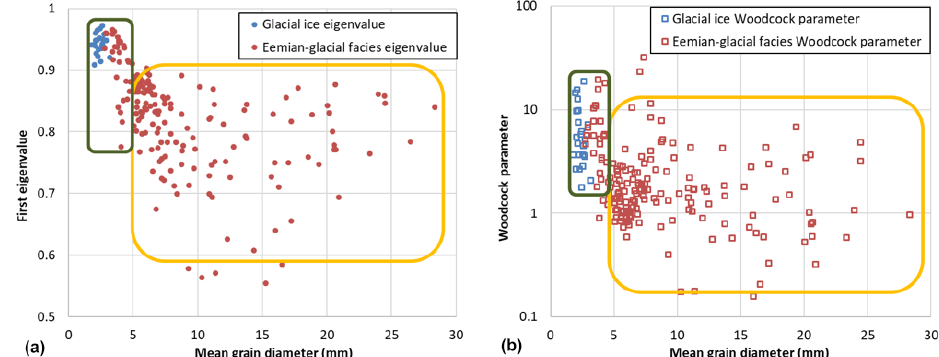
Figure 3. (a) The first c axis eigenvalue (dots) and (b) the Woodcock parameter (open squares) per FA image versus the mean grain diameter of the ice core sections in the lower part of the glacial ice (2000–2207m depth) in blue and the Eemian-glacial facies (2207–2540m depth) in red. Two classes of grains can be distinguished based on mean grain diameter, eigenvalue and Woodcock parameter. One class (green rectangle) has a fine mean grain size < 5mm and a first eigenvalue and Woodcock parameter that are comparable to the Glacial ice and the other class (yellow rectangle) with a larger mean grain diameter ( > 5mm) that has a lower eigenvalue and predominantly lower Woodcock